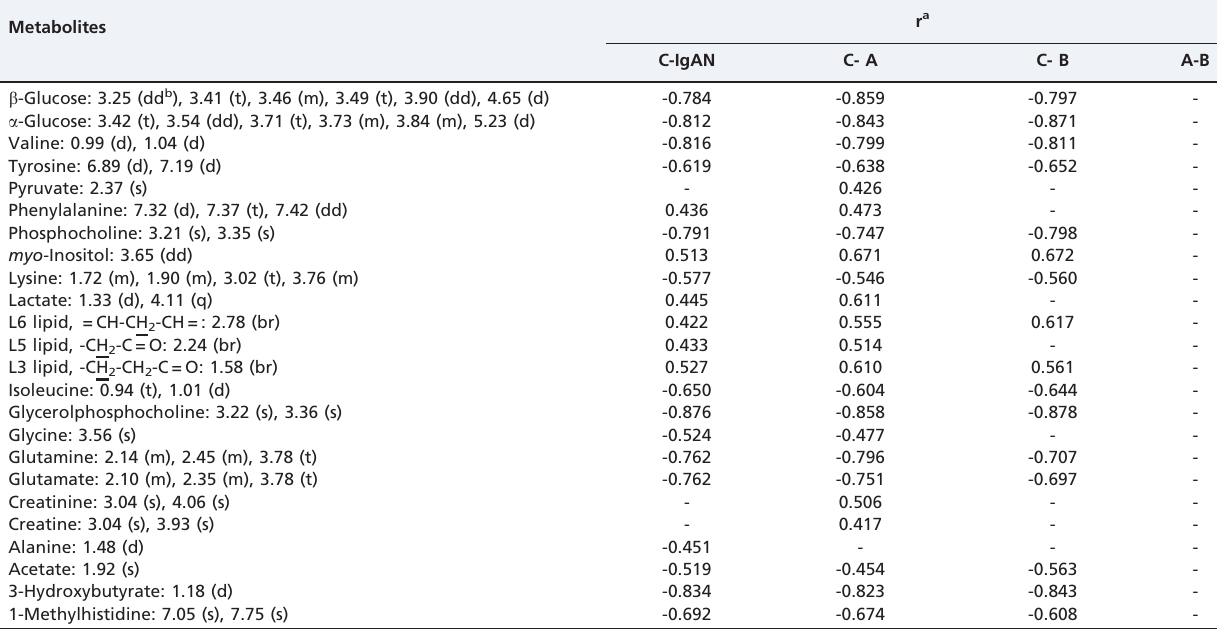
Table 4 - Summary of the 1 H NMR-detected statistically significant changes in the relative levels of serum metabolites for IgAN patients compared with the healthy controls.